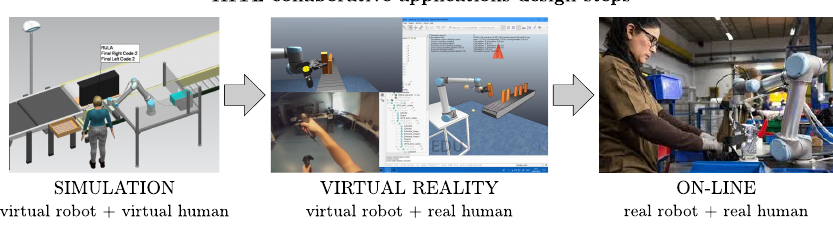
Figure 8. Design steps of a human in the loop (HITL)